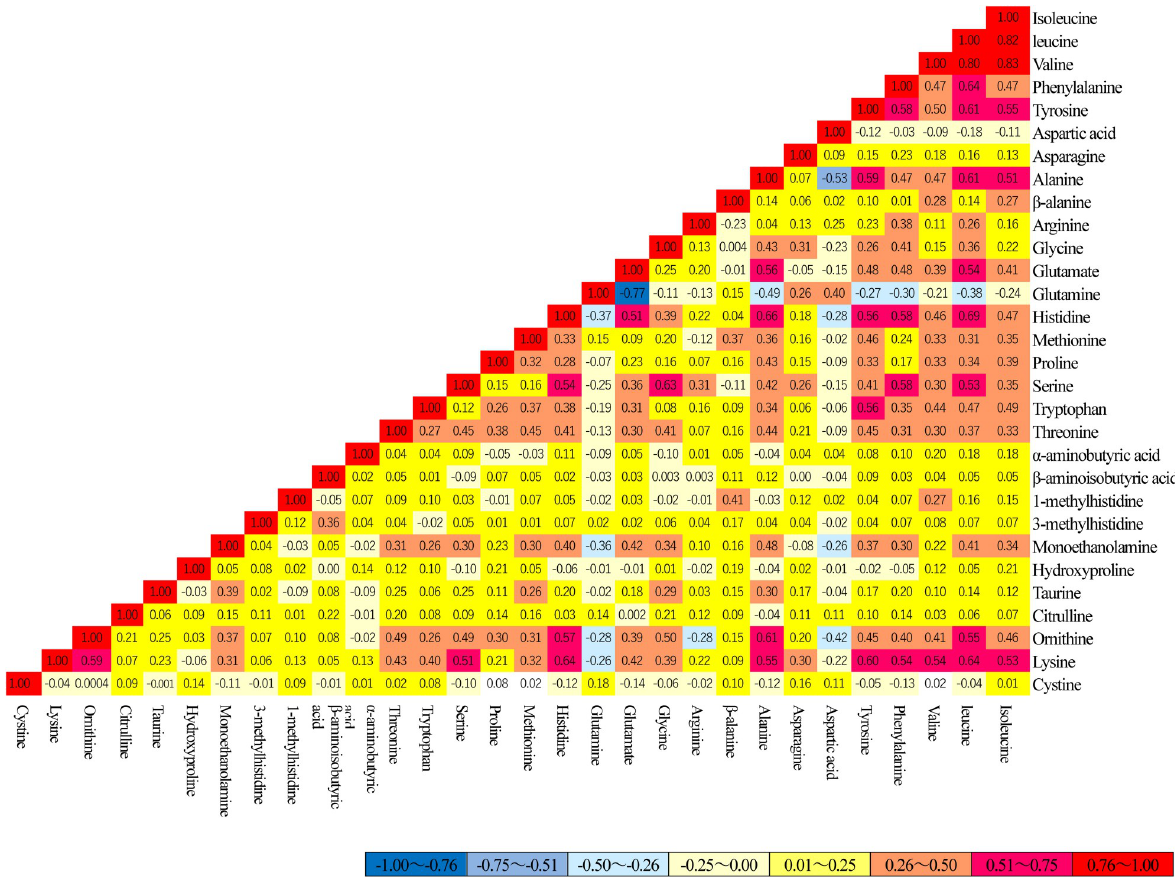
Fig 2. The correlations across serum amino acid concentrations at baseline. Abbreviation: CES-D, Center for Epidemiologic Studies Depression Scale.